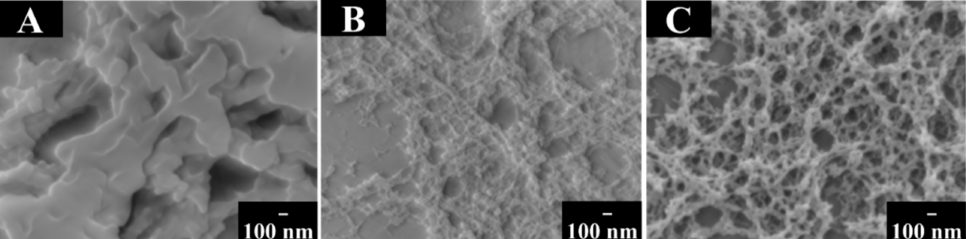
Figure 7. SEM images of as-deposited and room-temperature-dried coatings: ( A ) PMMA- ibuprofen, ( B ) PMMA-tetracycline and ( C ) PMMA-amoxicillin coatings.